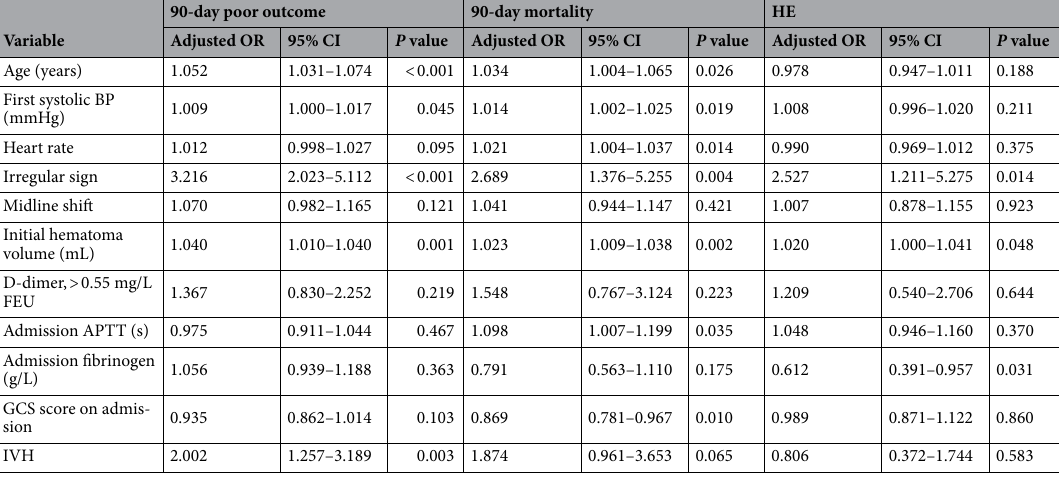
Table 3. Multiple associations with Poor Functional Outcome (mRS 3–6) and Mortality and Hematoma expansion. BP = blood pressure; CI = confidence interval; GCS = Glasgow Coma Scale; ICH = intracerebral hemorrhage; IVH = intraventricular hemorrhage on presentation; mRS = modified Rankin Scale. Values are n (%), mean ± SD, or median (interquartile